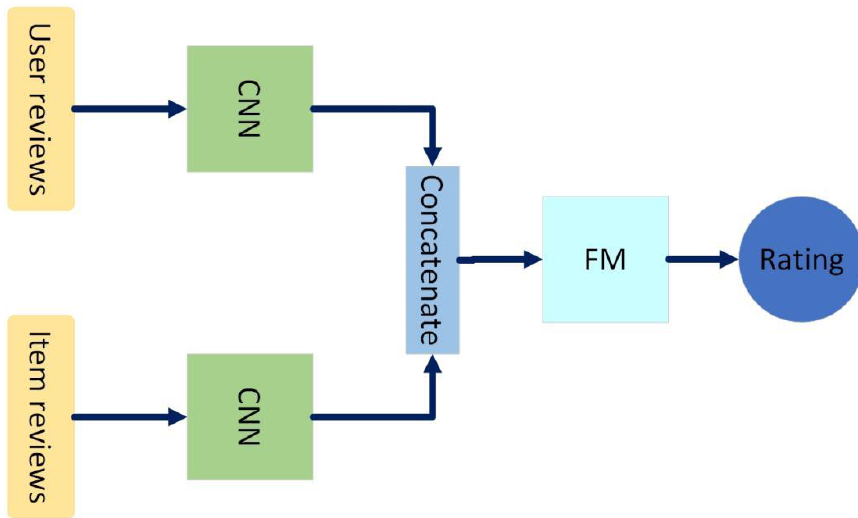
Figure 1. The architecture of the DeepCoNN model.